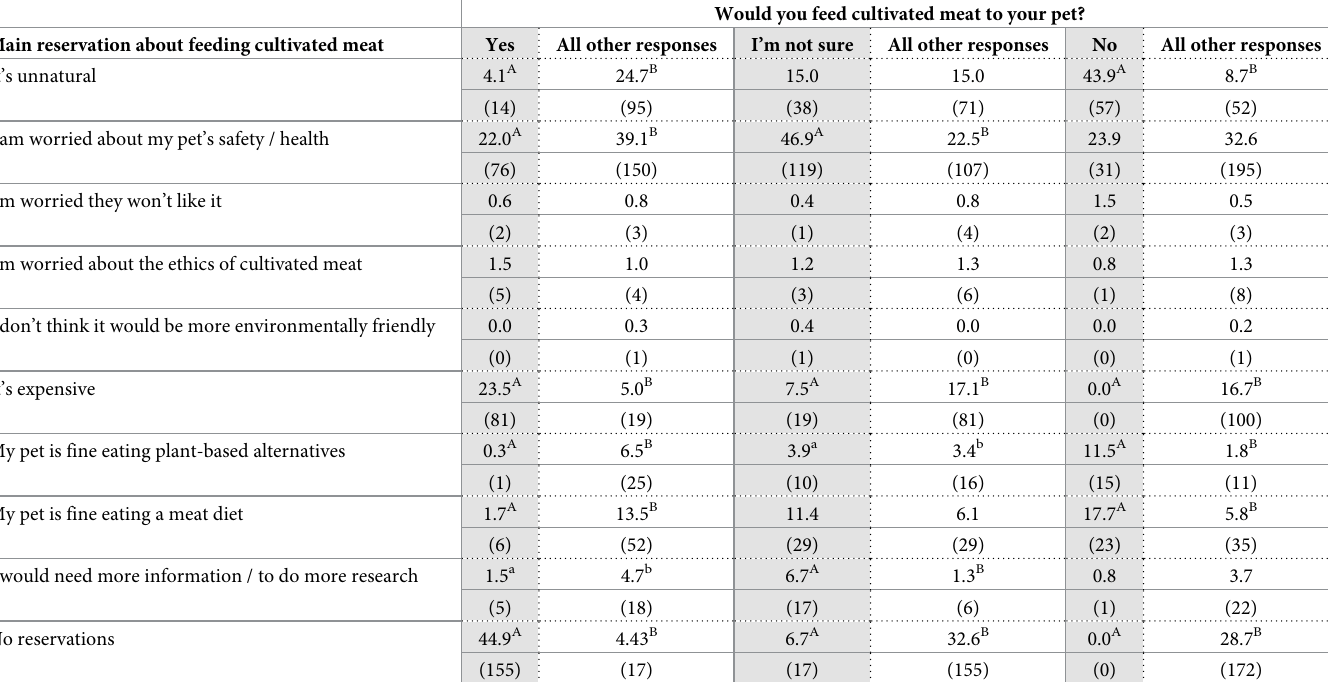
Table 7. Willingness to feed cultivated meat, by main reservation about feeding cultivated meat to